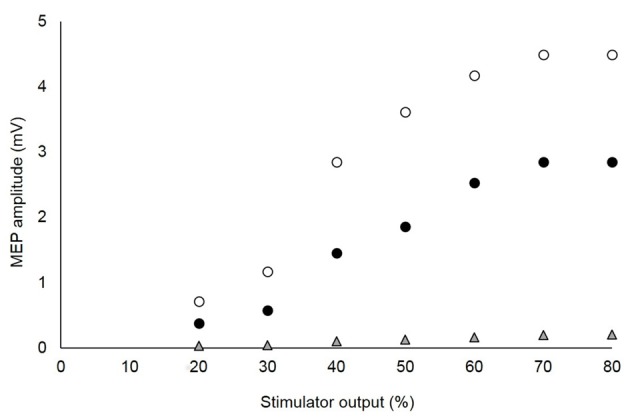
Stimulus-response curves of motor evoked potentials (MEPs) recorded from agonist and antagonist muscles in a single, representative subject. The optimal stimulation intensity was that which showed a plateau of the vastus lateralis (VL; white circles) and rectus femoris (RF; black circles) MEPs, without a marked increase of the MEP for the antagonist biceps femoris (BF; gray triangles). For this subject, 70% of the maximal stimulator output was chosen as the optimal intensity.